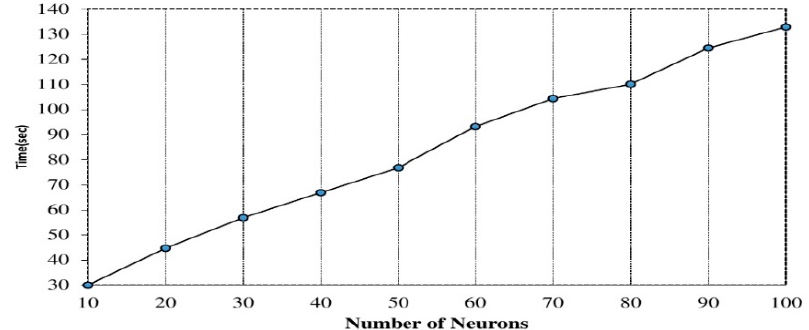
Figure 4. Computational time on increasing the hidden neurons.